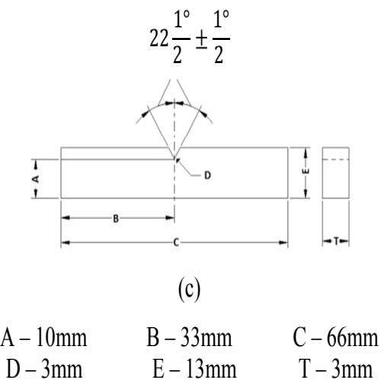
ine Diagram Test Samples as per ASTM Standard